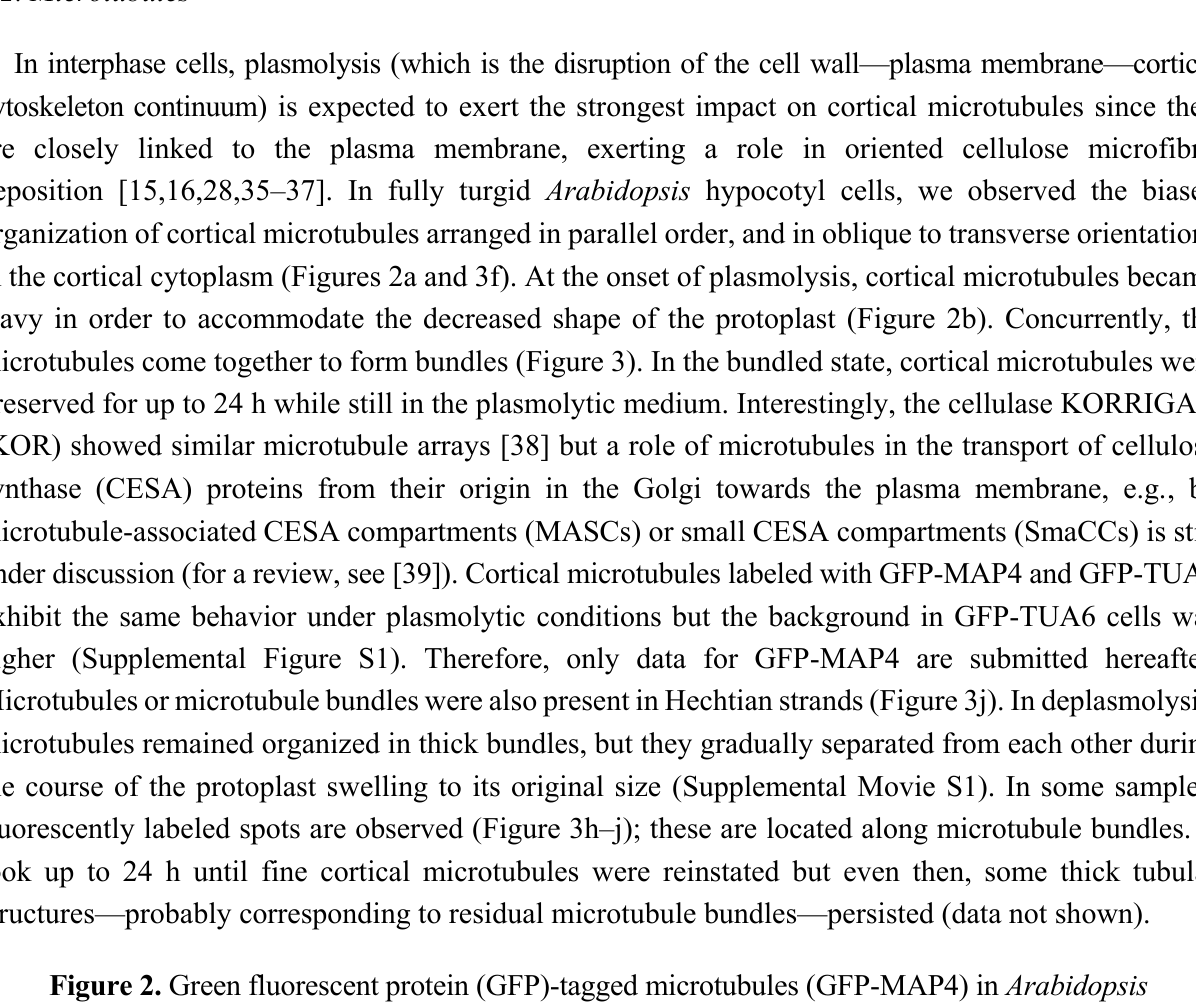
Figure 2. Green fluorescent protein (GFP)-tagged microtubules (GFP-MAP4) in Arabidopsis hypocotyl cells; ( a ) Interphase cells before plasmolysis; ( b ) Bundles and wavy